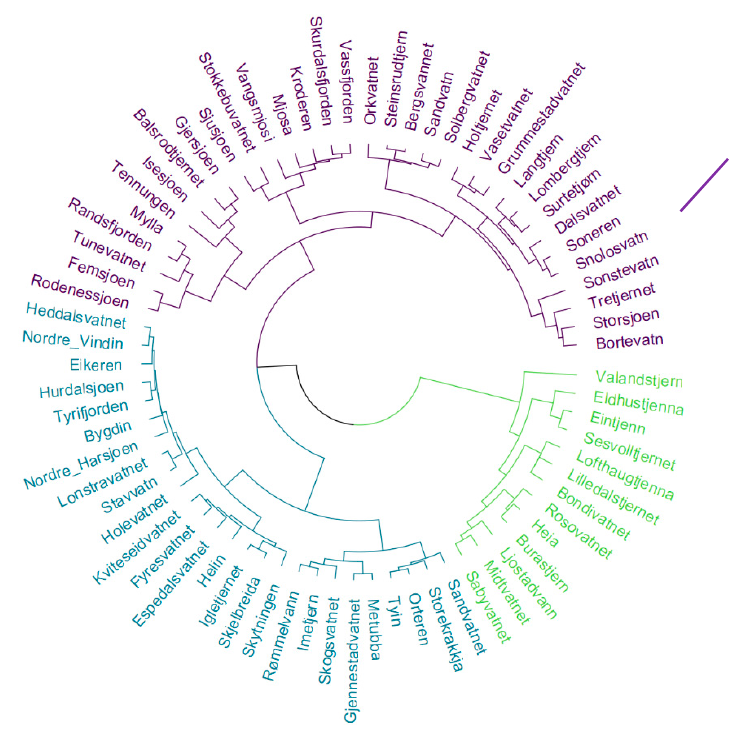
Figure 2. Dendrogram of the 73 sampling sites sorted by similar bacteria classes. Different colours show the three main clusters. The inoculum was sampled in “Langtjern”. Computations were performed with the “factoextra” and “dendextend” packages in R.